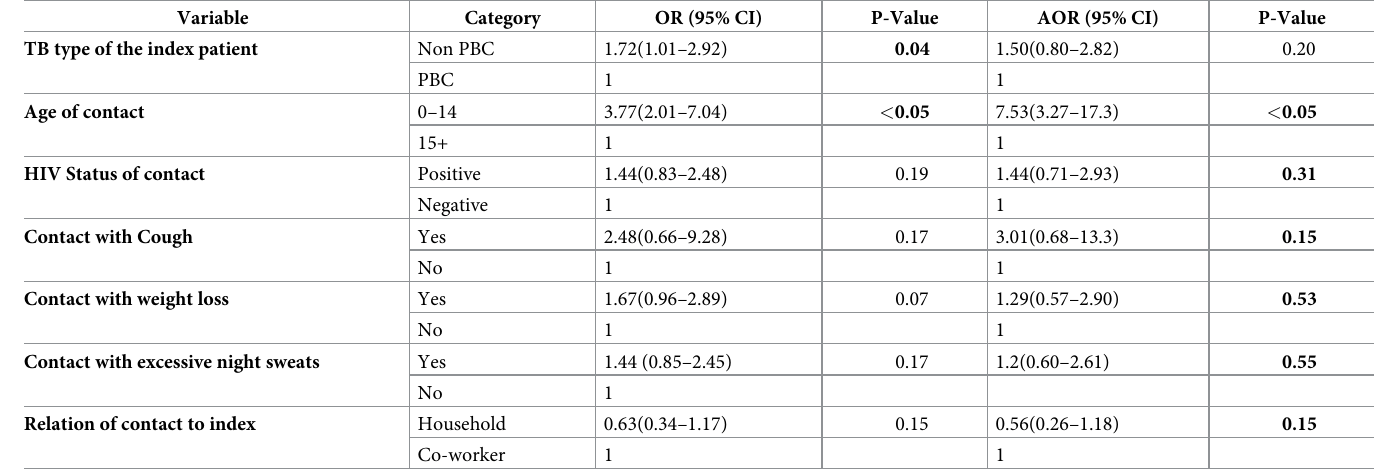
Table 4. Logistic model of the characteristics associated with diagnosing contacts as non PBC TB